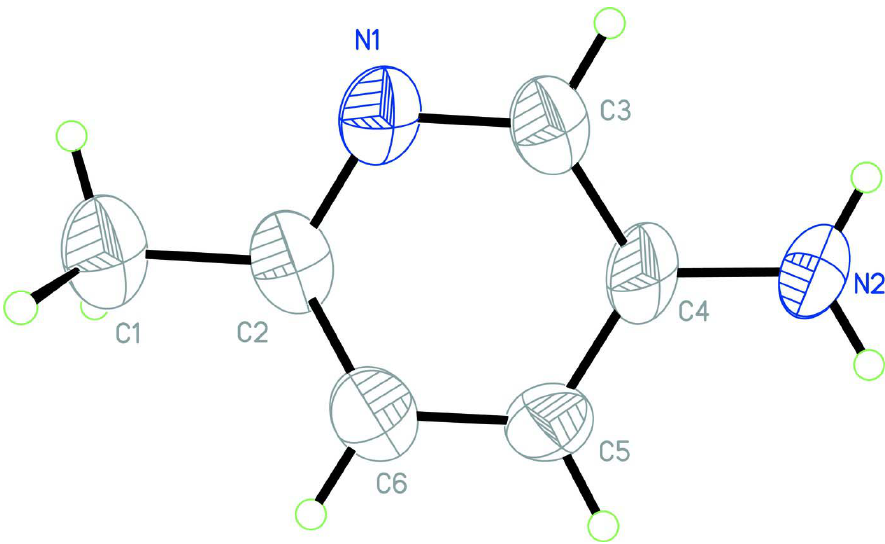
Figure 1 The molecular structure of the title molecule, with the atom-numbering scheme. Displacement ellipsoids are drawn at the 30% probability level.